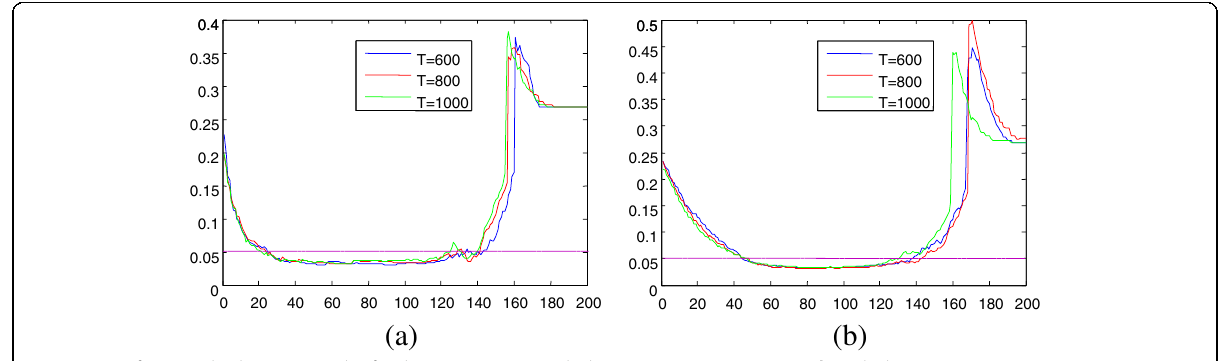
Fig. 14 ME of our method versus T and α for the rice image. a With the Gaussian noise (0, 0.010). b With the Gaussian noise (0, 0.020)